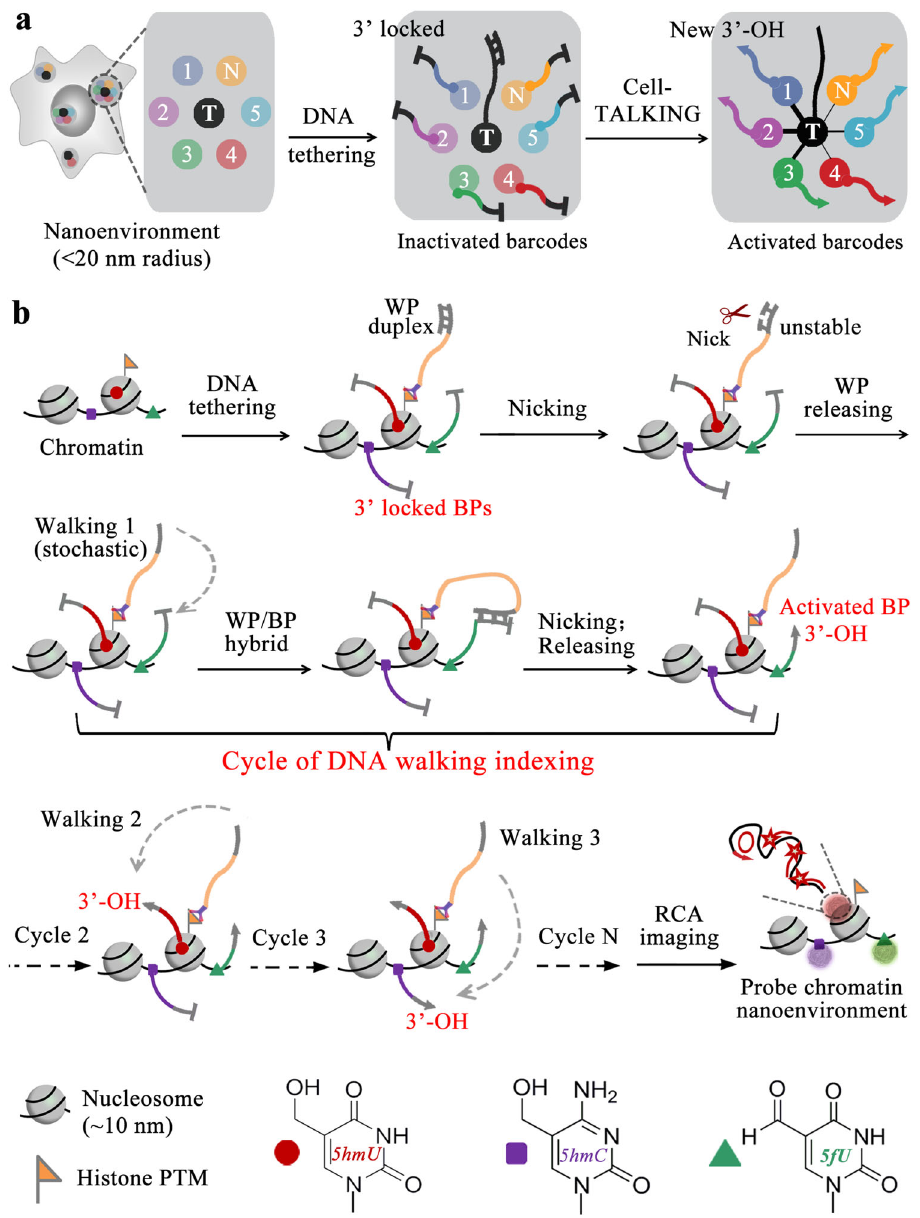
which will be detected by DNA ampli fi cation. b Schematic work fl ow of probing the nanoenvironment of chromatin modi fi cations using Cell-TALKING.